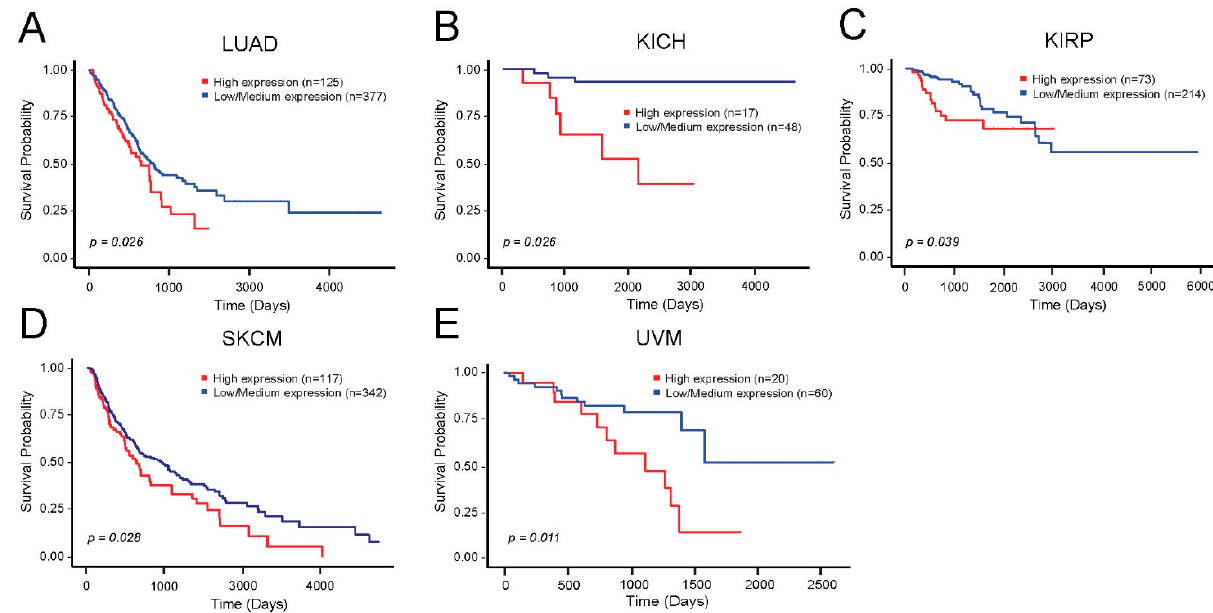
Figure 5. PSMD3 expression correlates with worse OS in multiple human malignancies. TCGA survival data from UALCAN demonstrates that higher levels of PSMD3 mRNA expression correlated with worse outcomes as demonstrated in the Kaplan-Meier curves for ( A ) LUAD, lung adeno carcinoma; ( B ) KICH, kidney chromophobe; ( C ) KIRP, kidney renal papillary cell carcinoma; ( D ) SKCM, skin cutaneous melanoma; ( E ) UVM, uveal melanoma.